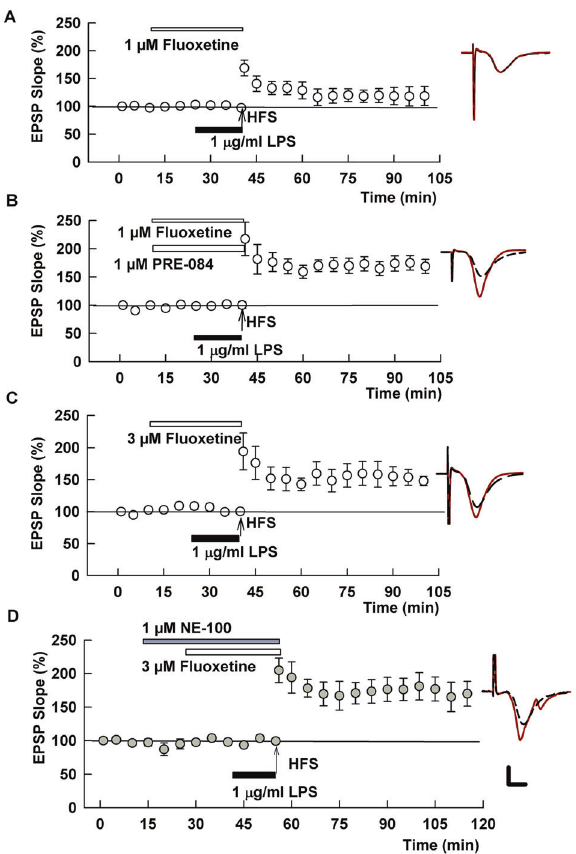
Fig. 3 The SSRI, fl uoxetine, overcomes the effects of LPS on LTP. A When administered at 1 μ M, fl uoxetine had partial, but non- signi fi cant effects on LPS-induced LTP inhibition. B A combination of 1 μ M fl uoxetine with 1 μ M PRE-084 completely overcame LPS. C Results in panel C prompted an examination of a higher concentration of fl uoxetine. At 3 μ M, fl uoxetine also completely overcame LPS. D Unlike fl uvoxamine, the S1R antagonist NE-100 had no effect on the ability of fl uoxetine to overcome LPS. Traces show representative EPSPs. Calibration: 1 mV, 5